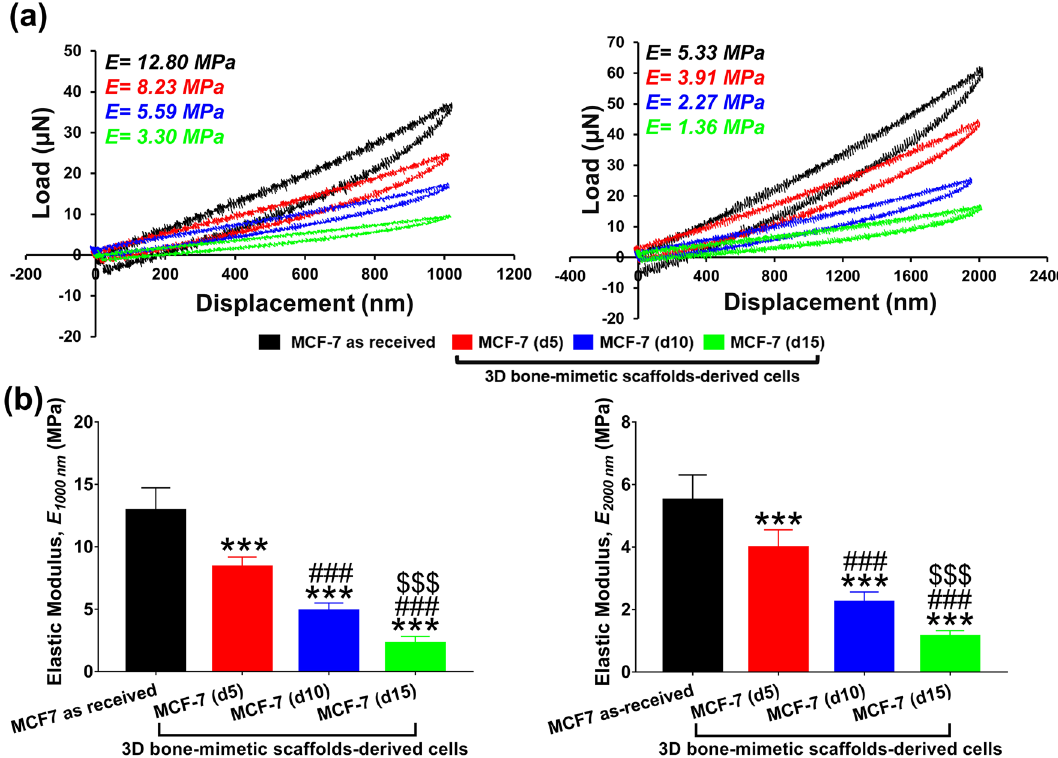
Figure 2. (a) Representative load–displacement (L-D) curves of MCF-7 as received, and 3D bone-mimetic scaffolds-derived MCF-7 cells at the maximum depth of 1000 nm and 2000 nm. (b) Elastic modulus of MCF-7 as received and 3D bone-mimetic scaffolds-derived MCF-7 cells at the maximum depth of 1000 nm and 2000 nm. For each measured sample, at least 20 cells were measured. Data are reported as a mean ± standard deviation (SD). *p < 0.05, **p < 0.01, and ***p < 0.001 indicate significant difference between MCF-7 as received and 3D bone-mimetic scaffolds-derived MCF-7 cells; # p < 0.05, ## p < 0.01, and ### p < 0.001 indicate significant difference between scaffolds-derived MCF-7 (d5), and other scaffolds-derived cells (i.e., MCF-7 (d10) and MCF-7 (d15)); $ p < 0.05, $$ p < 0.01, and $$$ p < 0.001 indicate significant difference between scaffolds-derived MCF-7 (d10) and MCF-7